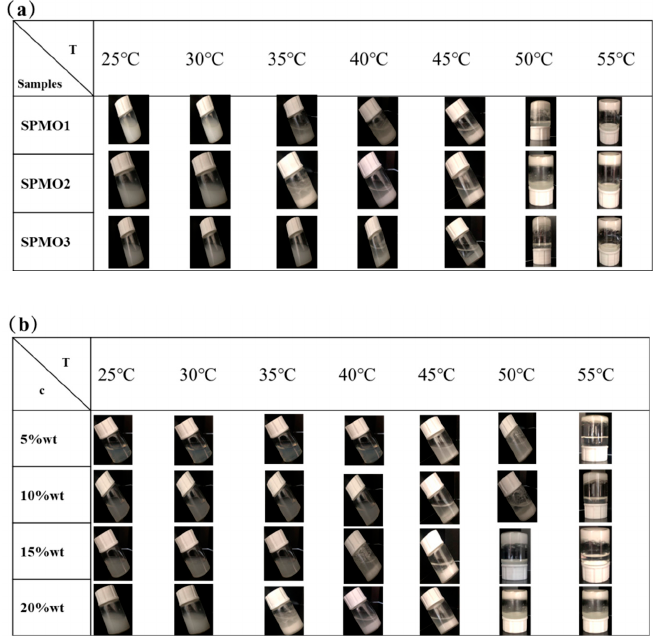
Figure 9. Photographs of SPMO copolymers aqueous solutions at different temperature: ( a ) SPMO1, SPMO2, and SPMO3 aqueous solutions (20 wt%) at different temperatures; ( b ) various concentrations of SPMO2 aqueous solutions at different temperatures.